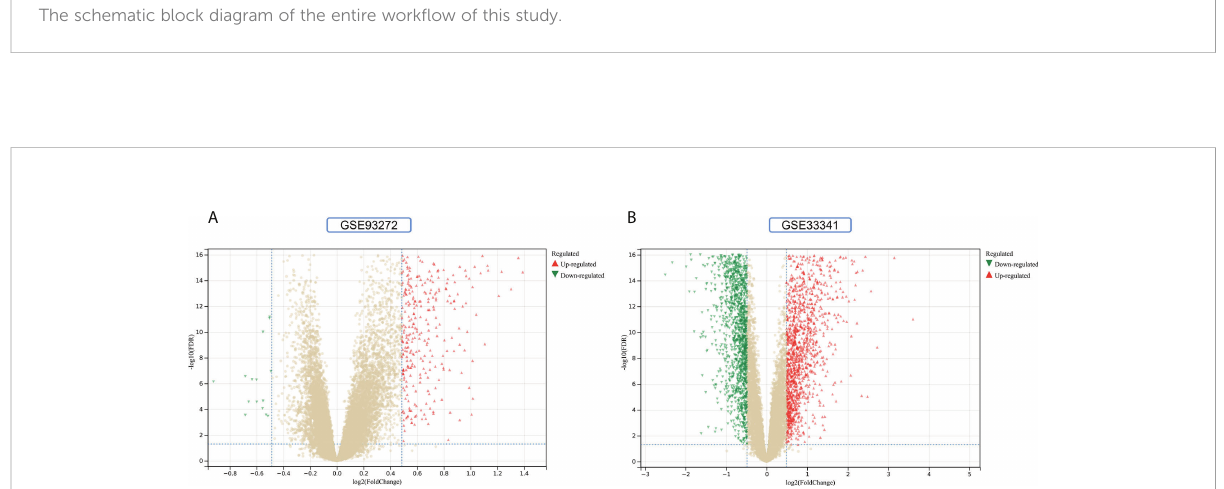
FIGURE 2 DEGs identi fi cation. (A) Gray dots represent genes not substantially differently expressed in RA and HC groups ( P > 0.05), red triangles represent upregulated genes ( P < 0.05), and green triangles represent downregulated genes ( P < 0.05) in the GSE93272 dataset. (B) Gray dots represent genes not substantially differently expressed in S. aureus and HC groups ( P > 0.05), red triangles represent upregulated genes ( P < 0.05), and green triangles represent downregulated genes ( P < 0.05) in the GSE33341 dataset.